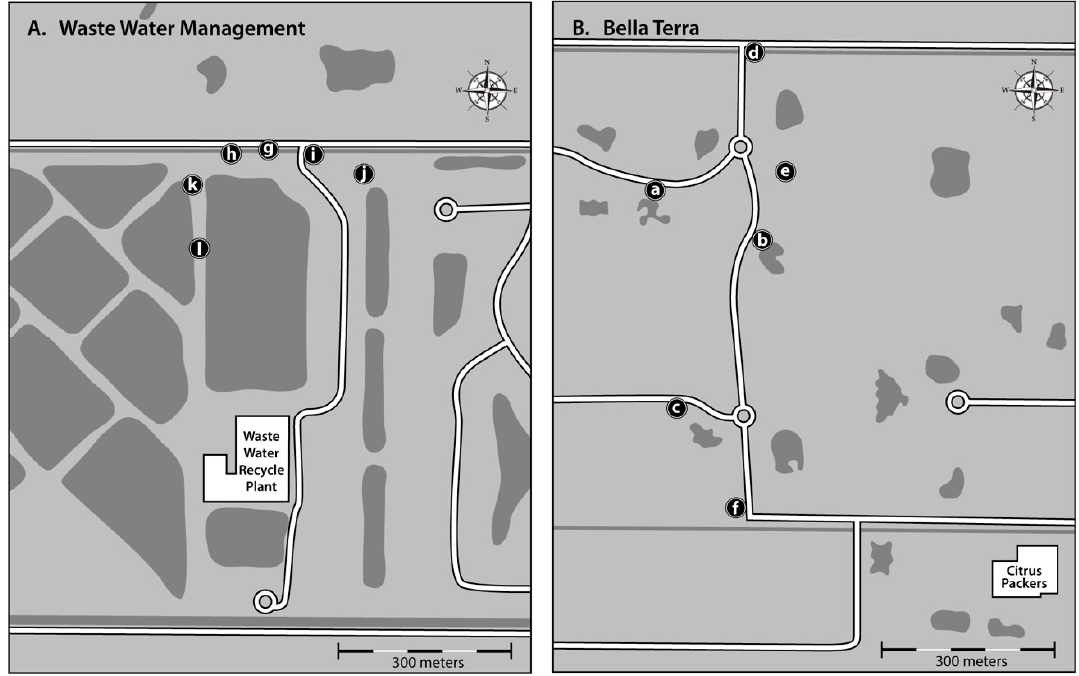
Figure 1. Locations of the oviposition traps: ( A ) Wastewater management facility area; ( B ) Bella Terra: residential subdivision.